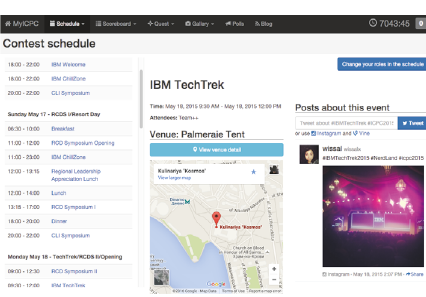
Figure 7: Schedule details page.